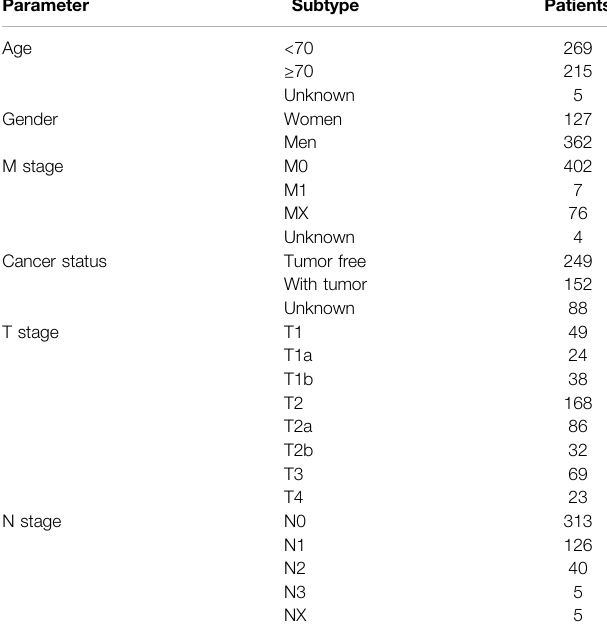
FIGURE 1 | Work fl ow of the bioinformatics